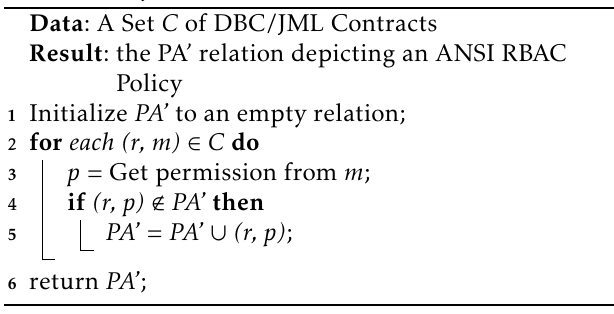
Algorithm R : Reconstructing an ANSI RBAC policy